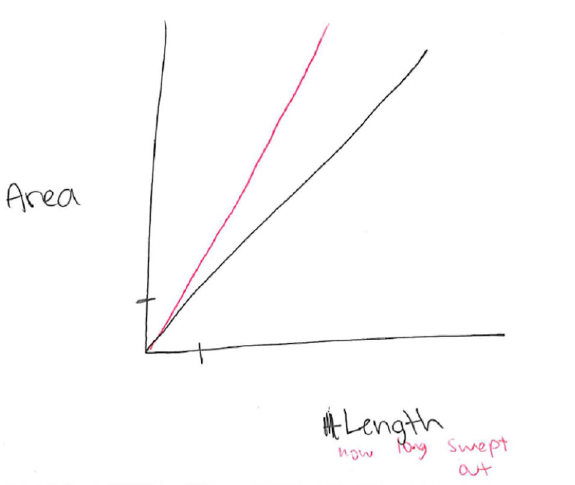
Figure 11. Olivia’s graph for the area painted versus the length swept for a shorter and taller paint roller.